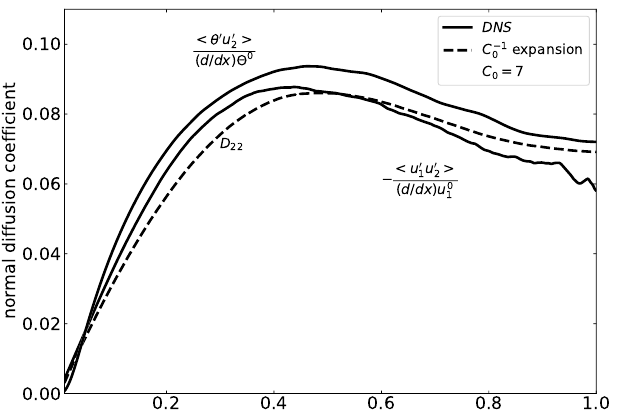
> and u (cid:48) 2 1 > / ( d / dx ) u 0 u (cid:48) 2 1 1 22